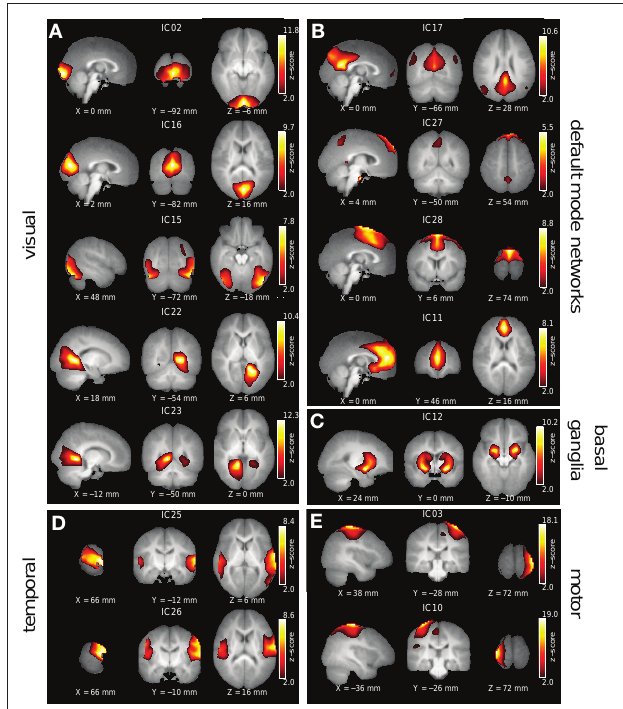
Figure 1 | group iCA estimated resting-state patterns grouped into: (A) Visual resting-state networks, (B) Default mode networks, (C) Basal ganglia, (D) Temporal networks, and (e) Motor networks. Group maps are z -scored and voxels above a z thresholded of 2 are displayed. The left hemisphere of the brain corresponds to the left side of the